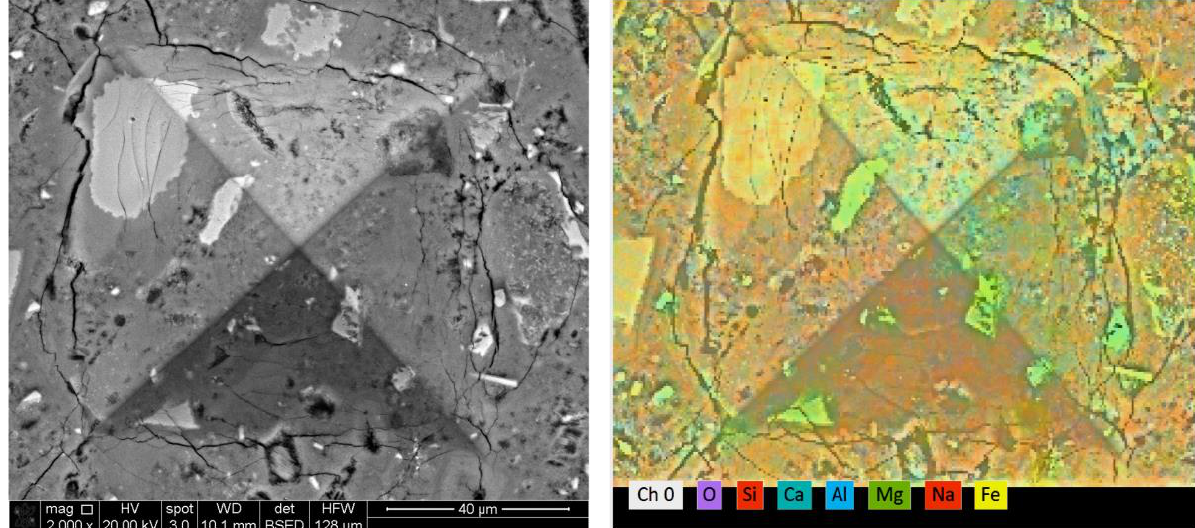
Figure 13. An EDS map corresponding to an SEM image showing a single indent on neat cement.